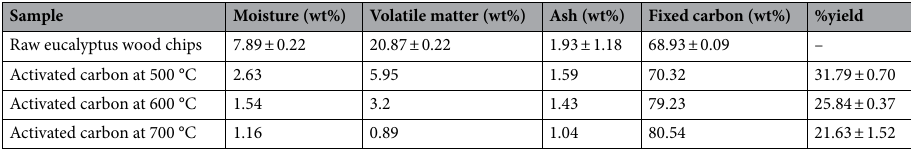
Table 1. Percent yield and proximate analysis of eucalyptus wood chips and activated